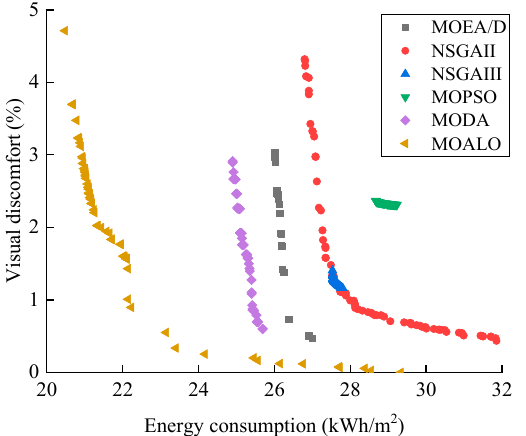
Figure 8. Pareto fronts for the different algorithms.